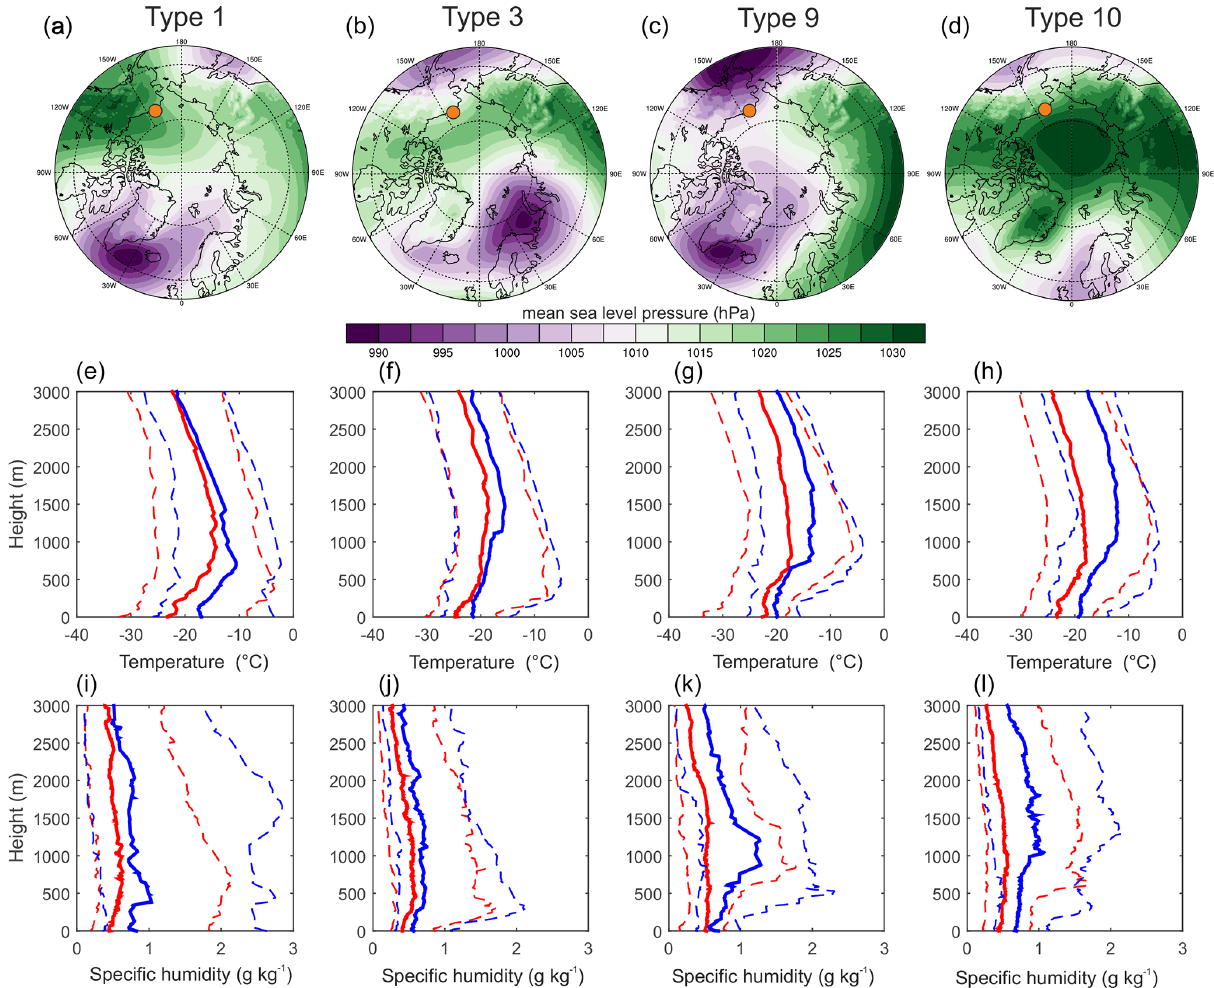
Figure 8. Median (solid lines), 10% percentile (dashed lines), 90% percentile (dashed lines) of temperature profiles (e–h) and specific humidity profiles (i–l) at Utqia˙gvik for four atmospheric circulation types (a–d) in winter during 2009–2018. The profiles are based on radiosounding observations. Red lines show radiatively clear profiles, blue lines radiatively cloudy profiles. The location of Utqia˙gvik is marked with a circle in (a) – (d)